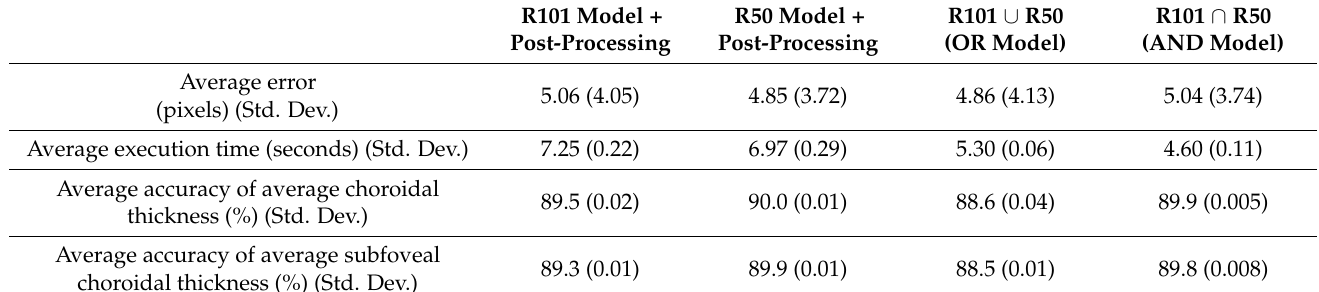
Table 2. Comparison of average error (in pixels), average execution time of each case (in seconds), and standard deviation via Mask R-CNN with different models. Average accuracy of average choroidal thickness measurement and average subfoveal choroidal thickness measurement (%) are shown at below.